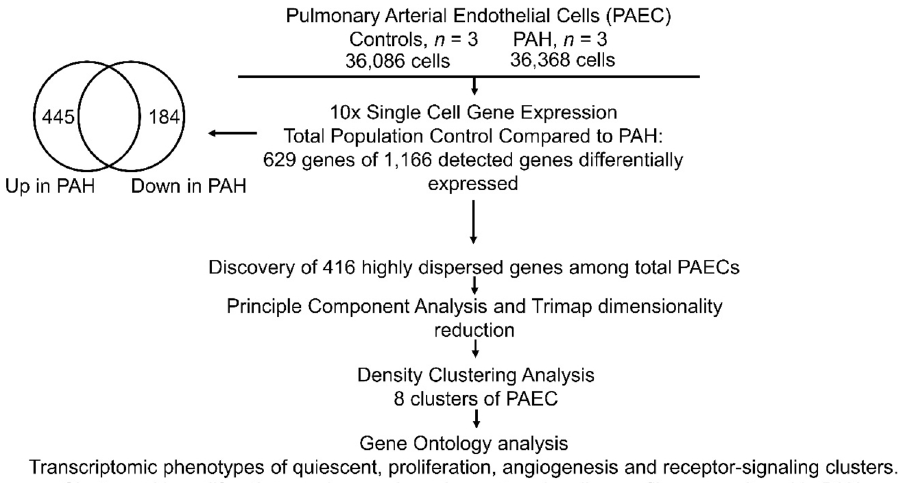
Figure 1. Overall work flow differential gene expression and clustering analysis. 10 × Single-Cell Omics was performed on PAEC derived from 3 control and 3 PAH lungs. The total number of cells in each sample was 36 K. Global gene expression analysis between the total populations of control and PAH cells revealed that 629 genes from 1,116 detected genes were differentially expressed. Among these, 445 genes were upregulated and 184 were downregulated in PAH. 416 highly dispersed genes were found in the total control and PAH population. Principle Component Analysis followed by Trimap dimentionality reduction was performed to depict the high-dimentional data in a two-dimentional space. Density Clustering Analysis identified 8 clusters of cells among control and PAH PAEC. Differential gene expression analysis of clusters in each sample, followed by gene ontology analysis of the differentially expressed genes showed that there were 4 transcriptomic profiles among the 8 clusters of PAECs. Three PAH clusters had an altered profile compared to the corresponding control